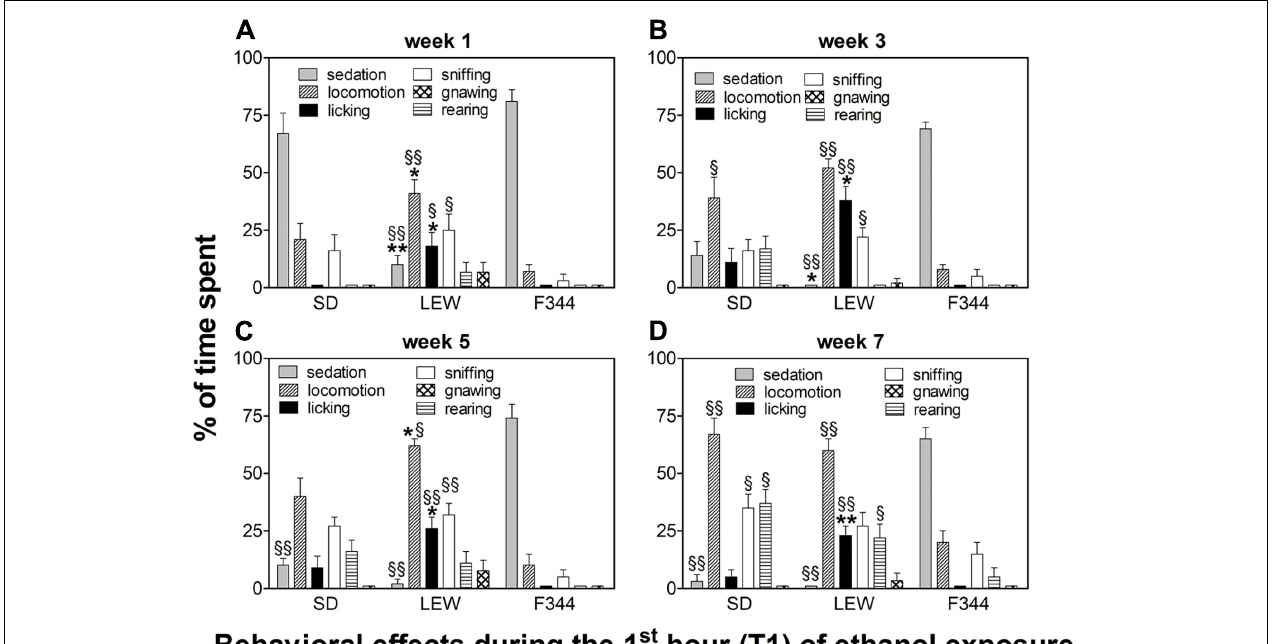
FIGURE 6 | Behavioral effects in adult onset rats during the first hour of the drinking session. Data are expressed as means ± SEM. (A) first week: data are referred to the first and third sessions of exposure. (B) third week: data are from the 9th session. (C) fifth week: data are from the 13th session; and (D) seventh week: data are from the 19th session. * p < 0.05 and ** p < 0.001 Lewis (LEW) vs. Sprague-Dawley (SD), § p < 0.05 and §§ p < 0.001 vs. corresponding value in Fischer 344 (F344) strain by one-way ANOVA followed by Tukey’s post hoc test.